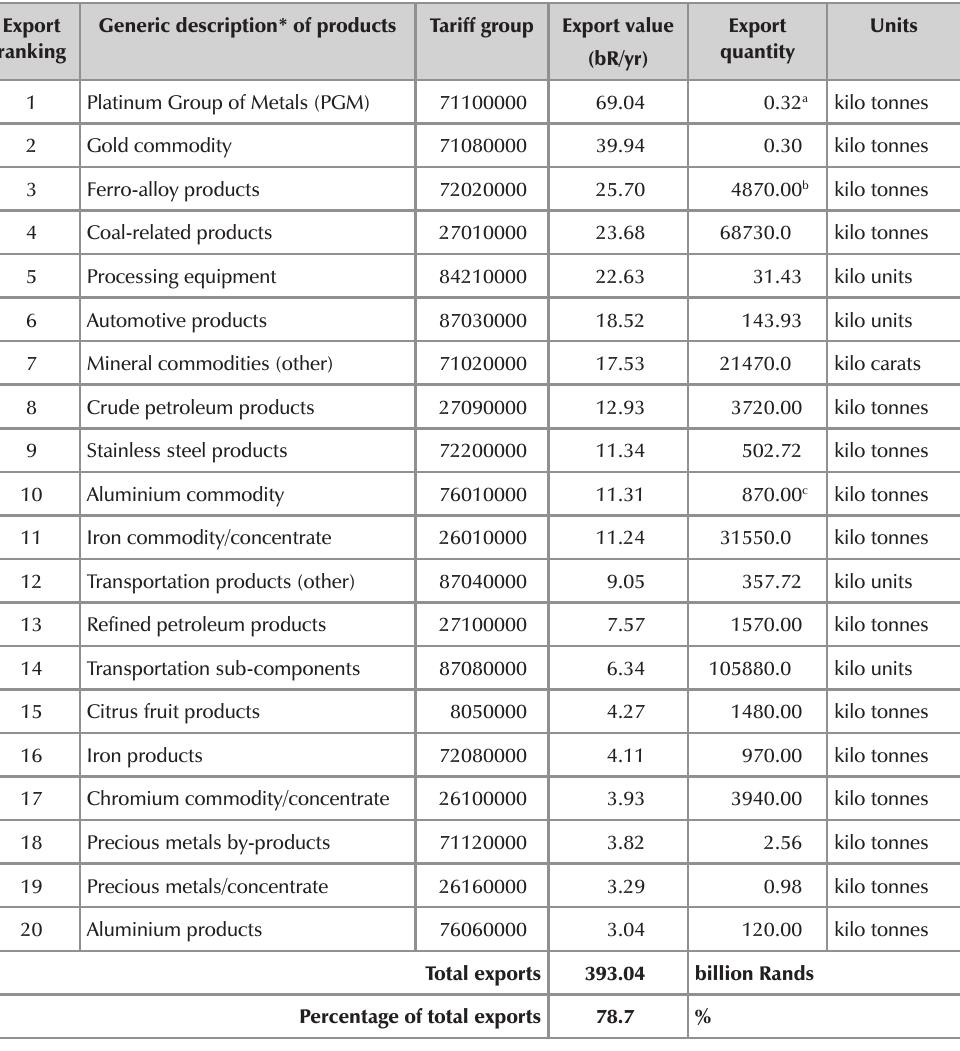
The top twenty exports of the South African economy prioritised based on